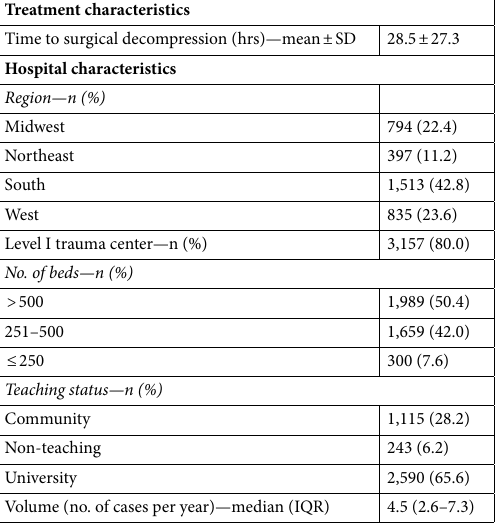
Table 1. Baseline characteristics of study cohort. MVC Motor Vehicle Collision; ISS Injury Severity Score; GCS Glasgow Coma Scale; ED Emergency Department; SBP Systolic Blood